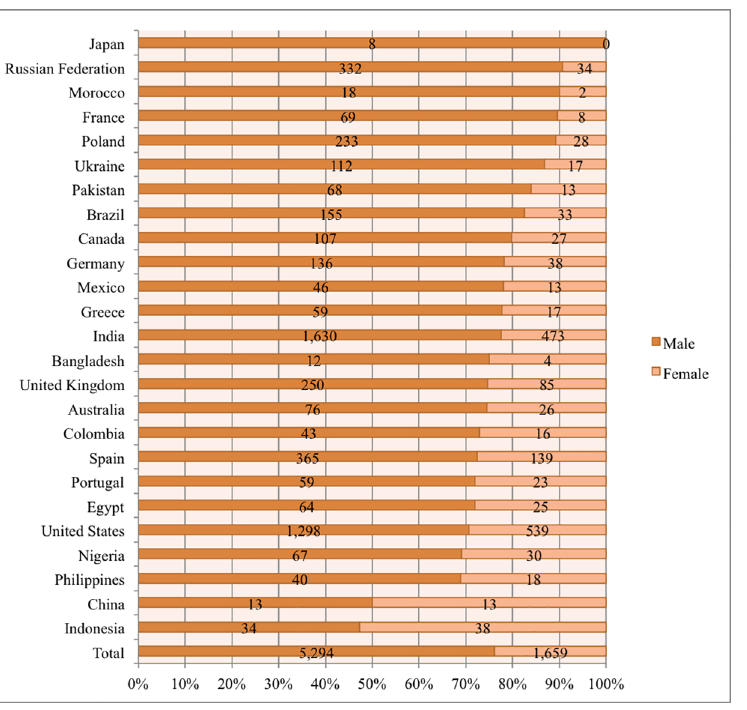
Fig 3. Number of males and females who completed one or more STEM MOOCs in each